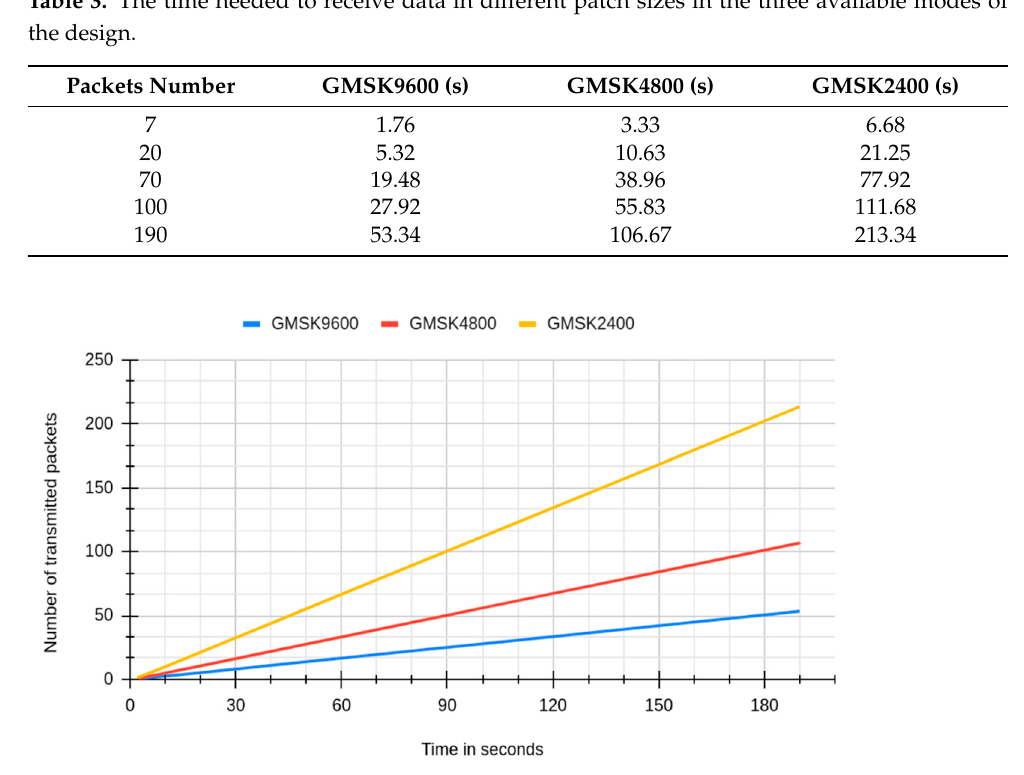
Figure 14. ( a – d ) Comparison of signals received in the 2400 bps GMSK mode with different SNR values. ( a ) SNR = − 3, ( b ) SNR = 5, ( c ) SNR = 9, ( d ) SNR = 14. ( e – h ) Comparison of the signals received in the 4800 bps GMSK mode with different SNR values. ( e ) SNR = − 3, ( f ) SNR = 5, ( g ) SNR = 9, ( h ) SNR = 14. ( i – l ) Comparison of the signals received in the 9600 bps GMSK mode with different SNR values. ( i ) SNR = − 3, ( j ) SNR = 5, ( k ) SNR = 9, ( l ) SNR = 14.